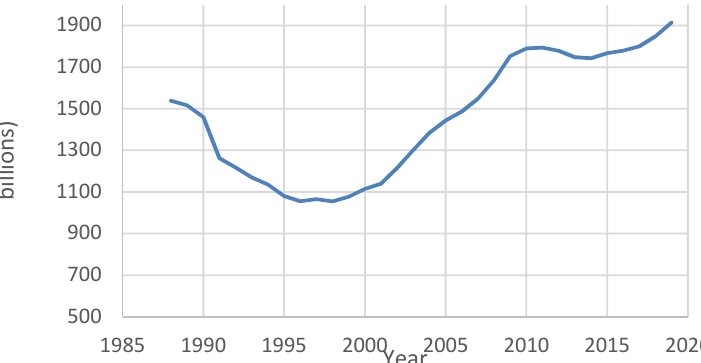
Figure 1. Global defense spending for period 1988 – 2019 1